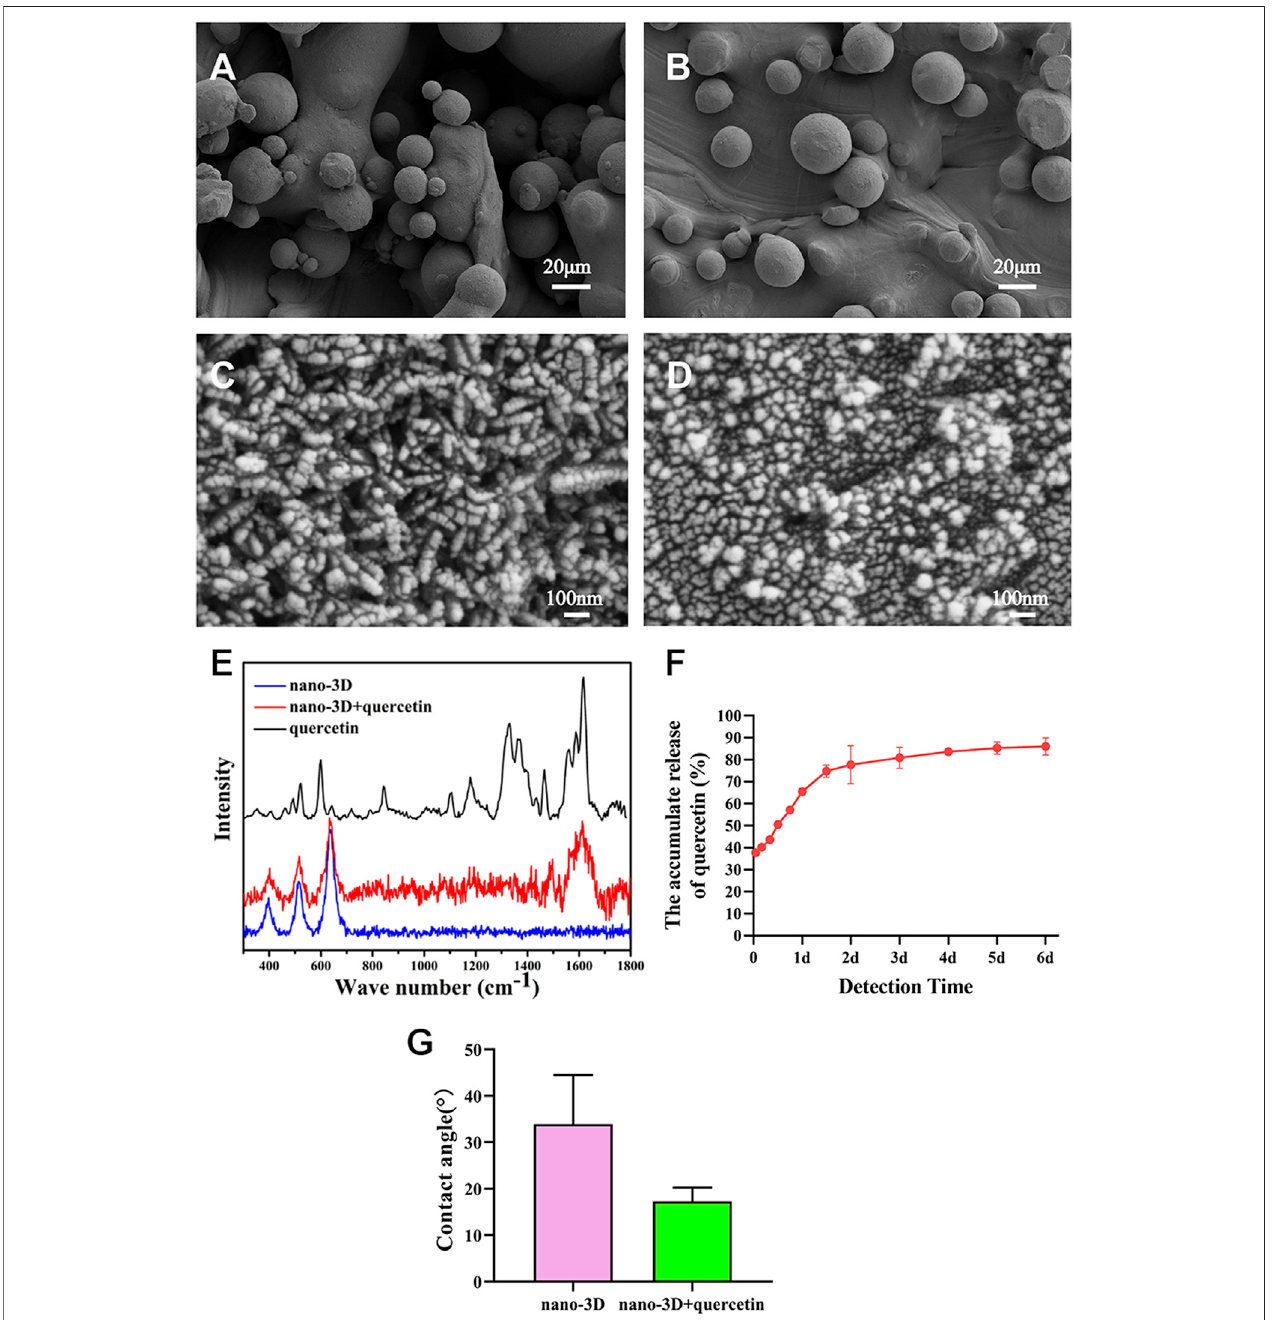
FIGURE 1 | SEM images of nano-3D (A,C) and nano-3D + quercetin (B,D) at low (A,B) and high magni fi cations (C,D) ; Raman spectra analysis (E) , accumulative release percentage of quercetin loaded on the nano-3D samples at different times (F) and water contact angle (G) of nano-3D/nano-3D + quercetin sample surfaces (* p <